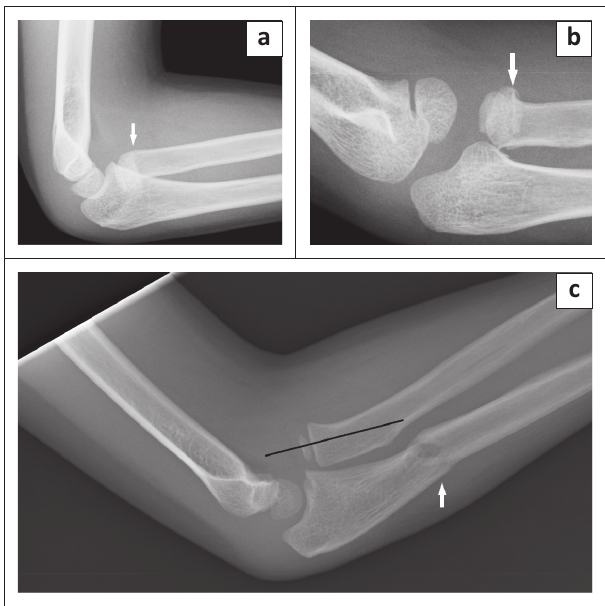
FIGURE 17: (a) Lateral and (b) oblique images of a four-year-old with a radial neck fracture (arrows). (c) A five-year-old with radial dislocation (note interrupted radiocapitellar line) and proximal ulnar